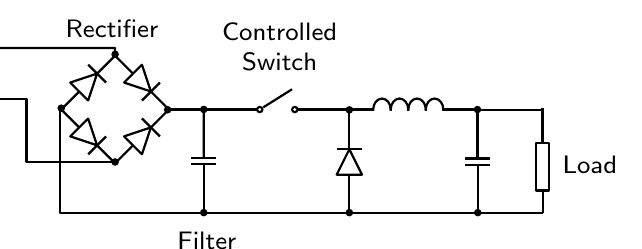
Figure 1. A simplified illustration of the switching regulator principle for AC–DC conversion.